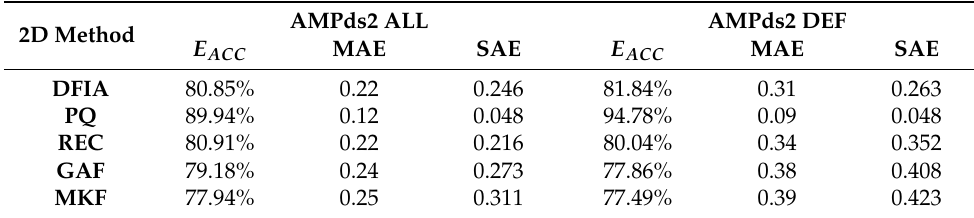
Table 5. Results for protocols #2 and #3 in terms of E ACC , MAE, and SAE for the low-frequency data of